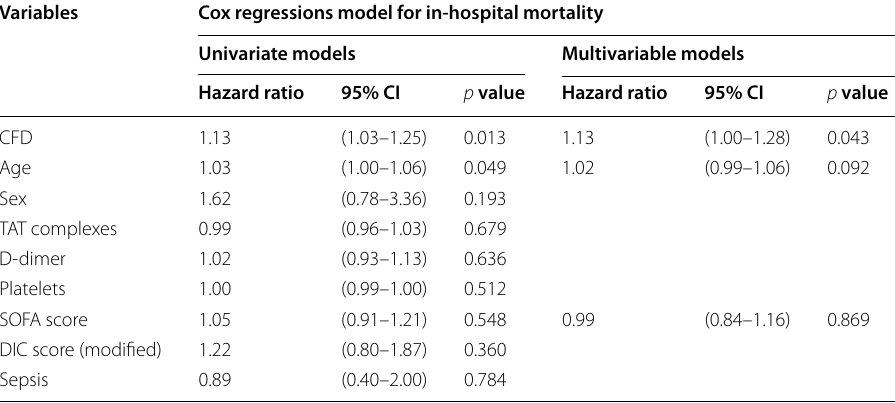
Statistics: univariate and multivariable Cox regression models (linear) and derived hazard ratios (HR) and confidence intervals (CI) with a coverage of 95% of demographic and clinical variables ( p < 0.05)